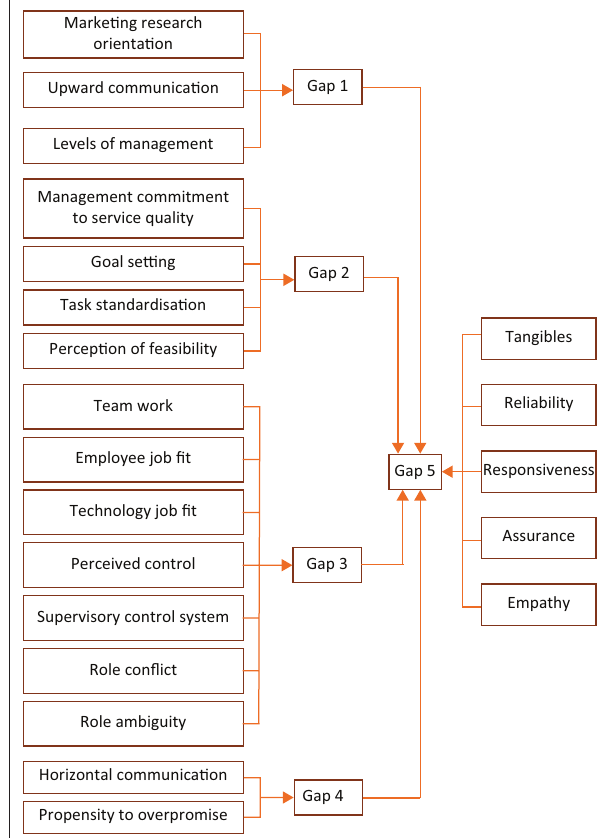
FIGURE 2: Model of service quality